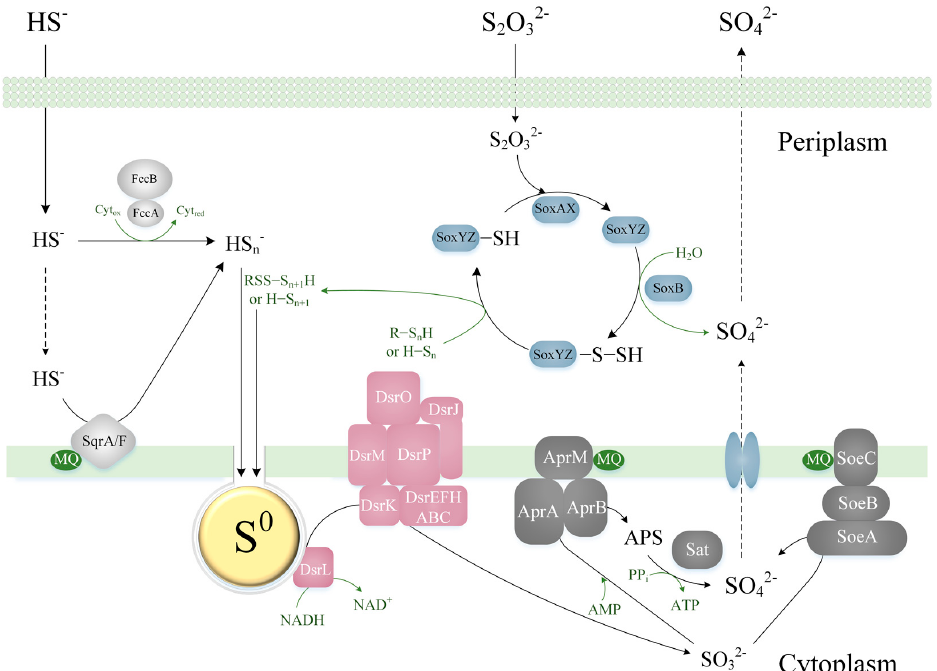
Figure 1. Scheme of dissimilation sulfur metabolism of the genus Thiothrix . FccAB, flavocytochrome c -sulfide dehydrogenase; SqrA/F, sulfide:quinone oxidoreductase; SoxAXBYZ, SOX multienzyme system; MQ, menaquinone; rDsrABCEFHEMPKJOL, dissimilatory sulfite reductase; AprABM, APS reductase; Sat, ATP sulfurylase; SoeABC, membrane-bound cytoplasmic sulfite:quinone oxidoreductase; S 0 , sulfur globule; APS, adenosine 5 ′ -phosphosulfate; R − S n+1 H, thiol compound; H − S n+1 , polysulfide.